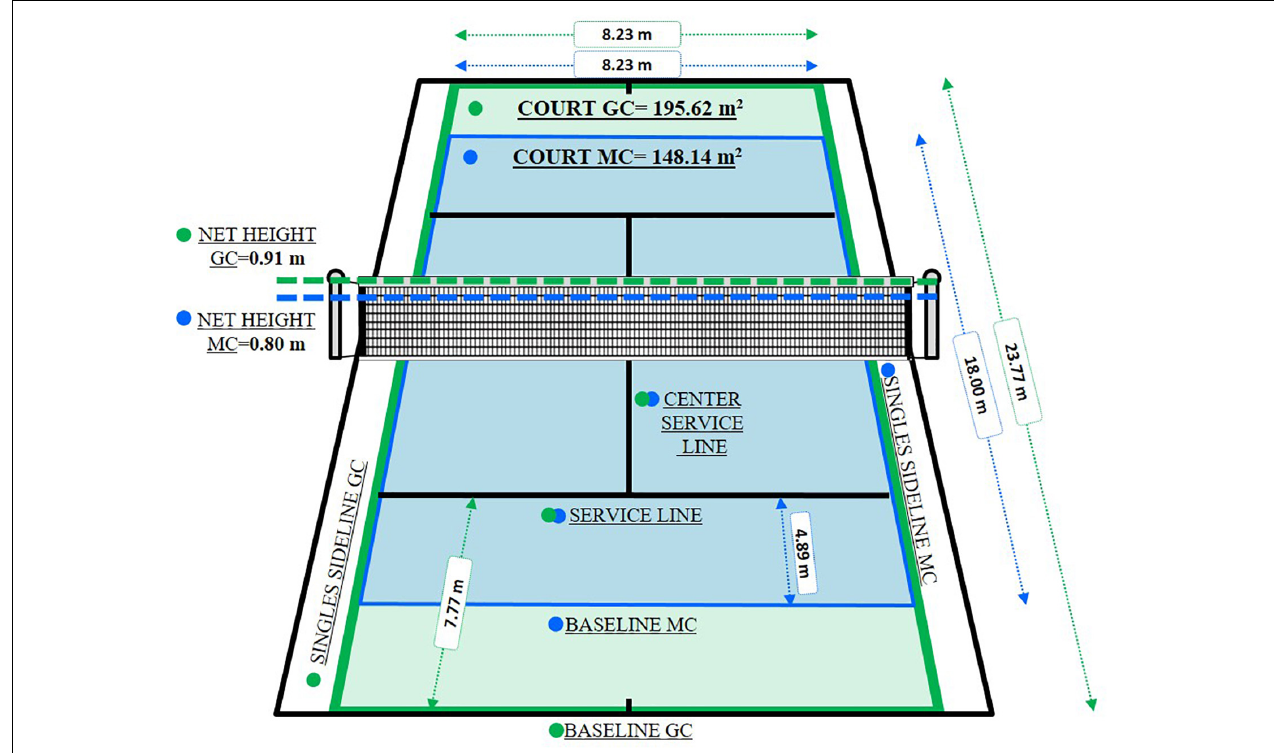
FIGURE 1 | Illustration of net height and court dimensions in both competitions (Tennis 10s Green Competition “GC” = green color and Modified Competition “MC” = blue color).